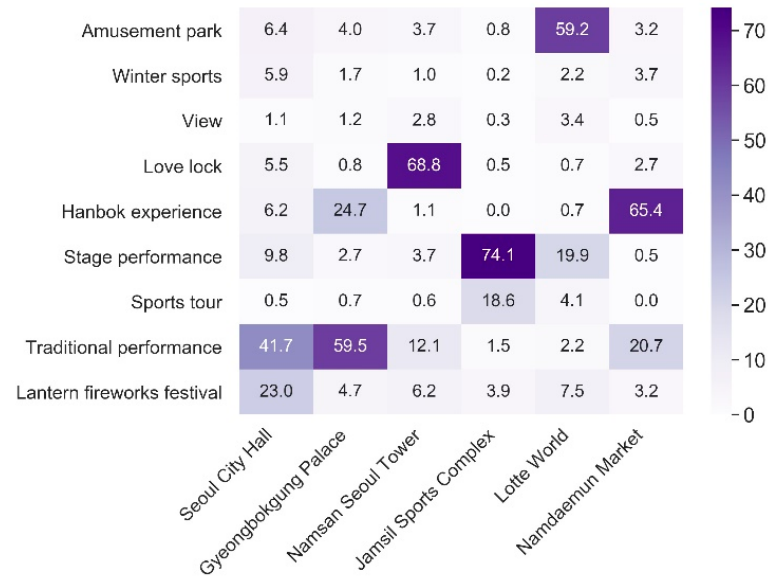
Figure 15. Popular activities in six regions of attractions for “Activities”